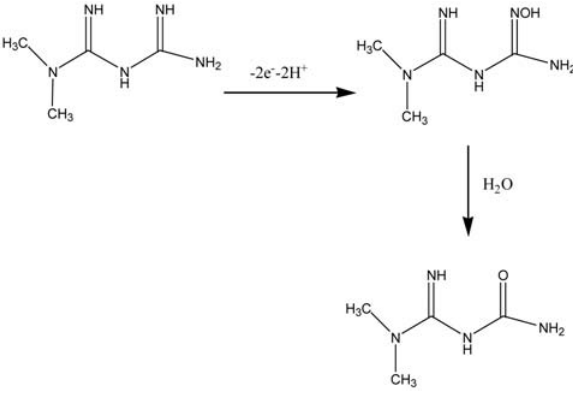
Figure 4: Suggested oxidation mechanism of